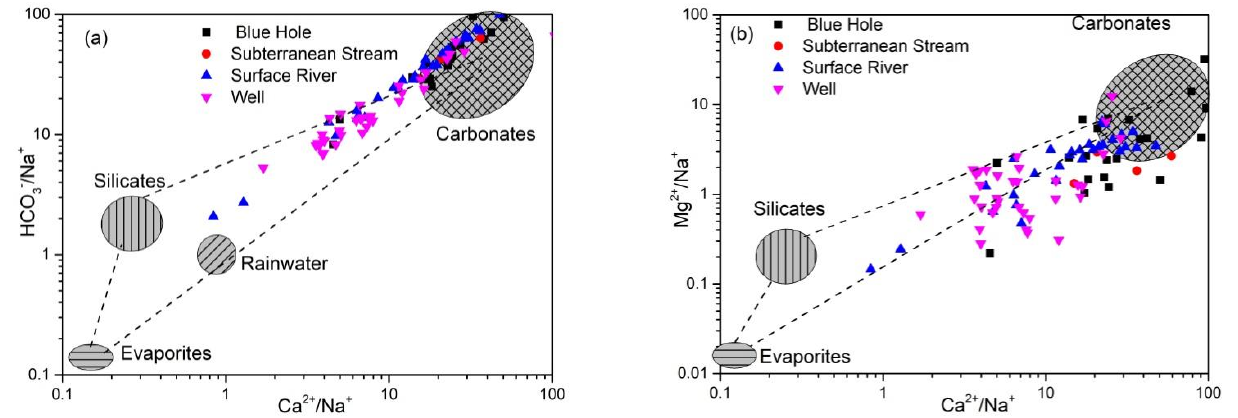
Figure 9. Relationships between major ions in the water of the Huixian karst wetland. ( a ) Ca 2+ /Na + vs. HCO 3 − /Na + , ( b ) Ca 2+ /Na + vs. Mg 2+ /Na + .